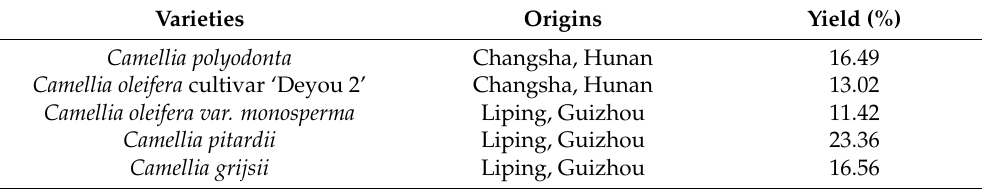
Table 7. The varieties, origins, and yield of 50% ethanol extract for different Camellia spp. fruit shells.